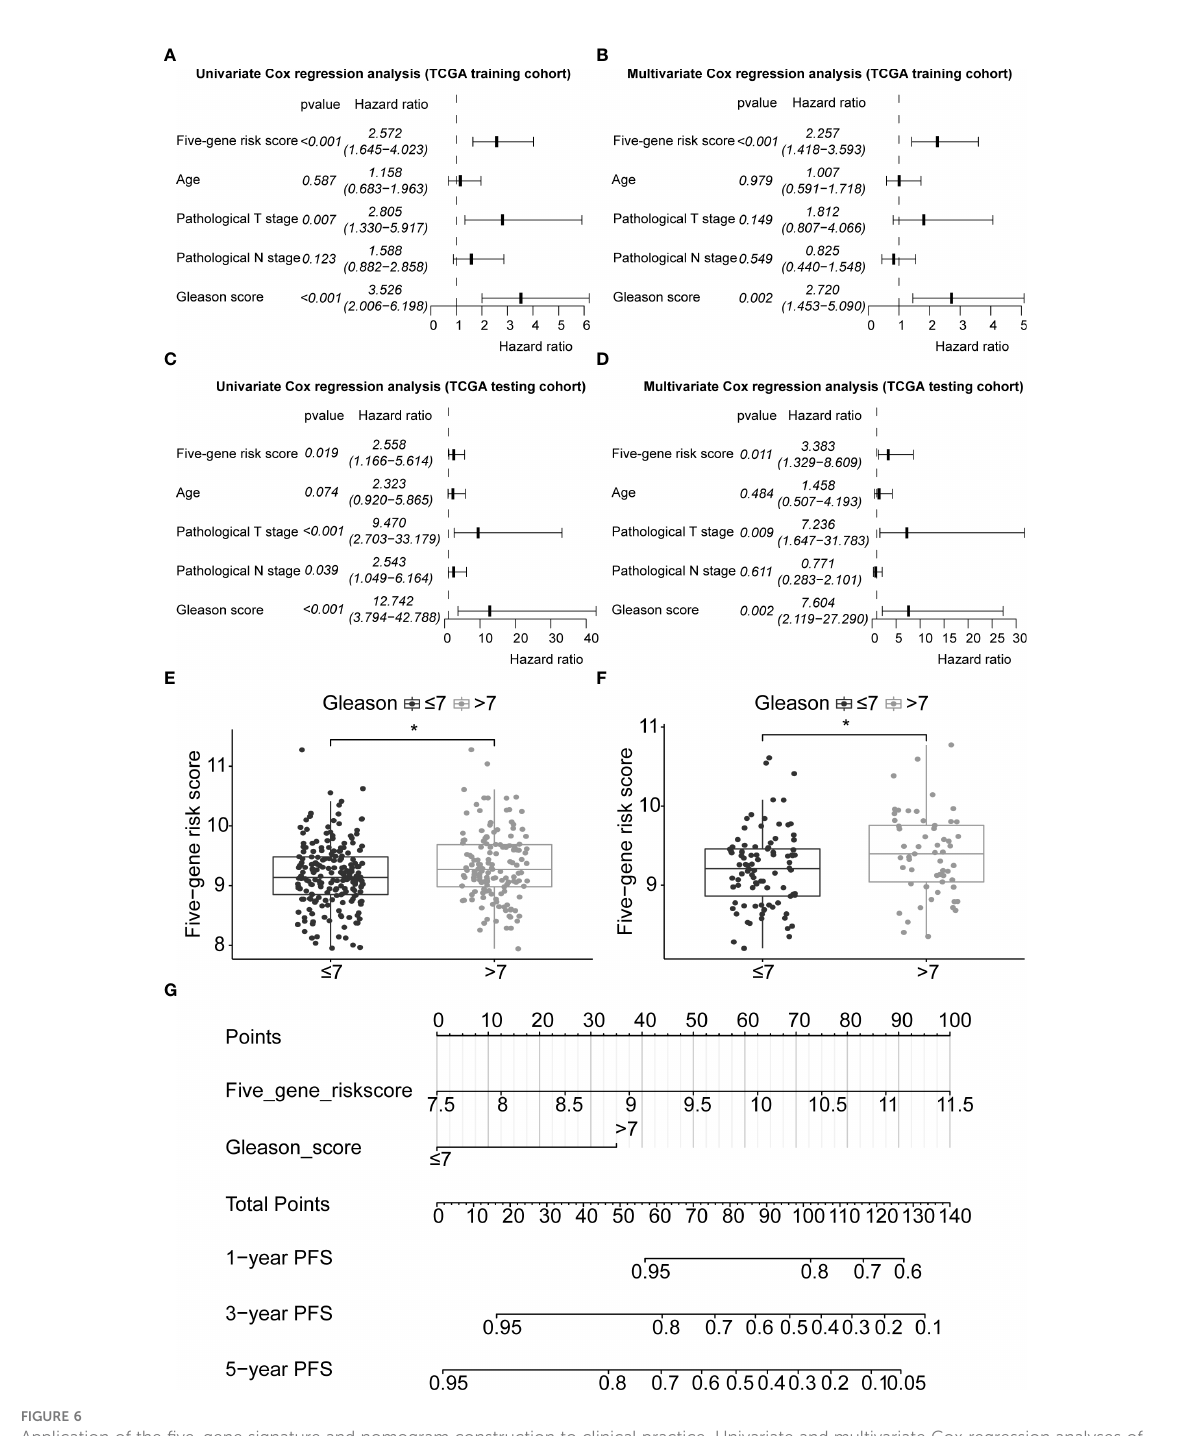
FIGURE 6 Application of the fi ve-gene signature and nomogram construction to clinical practice. Univariate and multivariate Cox regression analyses of the fi ve-gene signature risk score, age of the PCa patients at diagnosis, pathological T stage (tumour stage), pathological N stage (Lymph node status), and Gleason score in TCGA-PRAD training set (A, B) and TCGA-PRAD testing set (C, D) . Boxplots based on risk scores between Gleason scores ≤ 7 and >7 groups in TCGA-PRAD training set (E) and TCGA-PRAD testing set (F) . The signi fi cance of the risk score difference between the two groups is interpreted as asterisks (*p< 0.05). (G) Development of a nomogram to predict 1-, 3-, and 5-year PFS in the training set. PCa, prostate cancer; PFS, progression-free survival; KM, Kaplan – Meier; TCGA, The Cancer Genome Atlas; PRAD, prostate